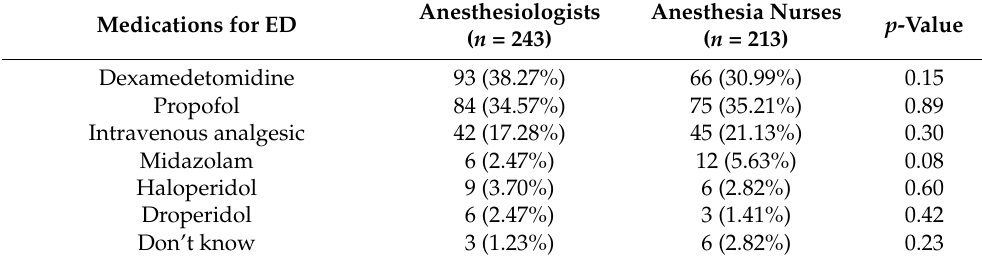
Table 5. Reported